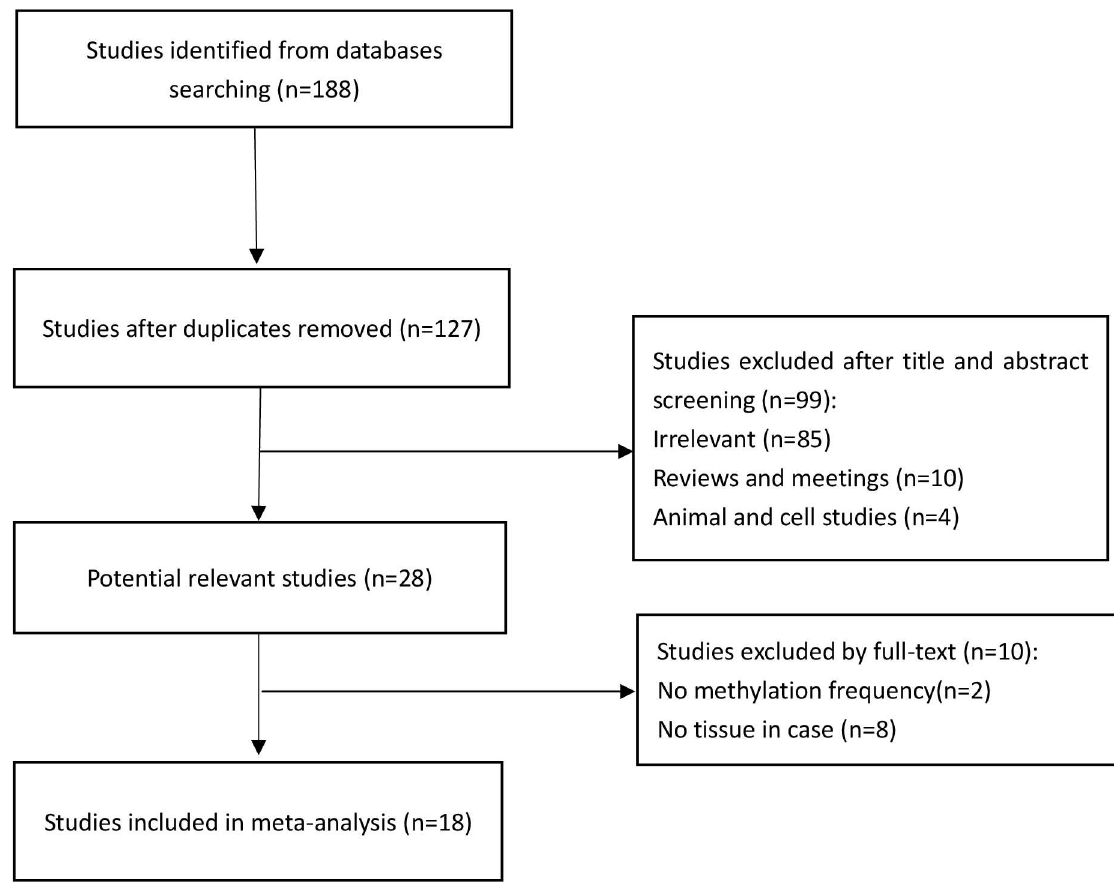
Fig 1. Flow chart of studies included in the